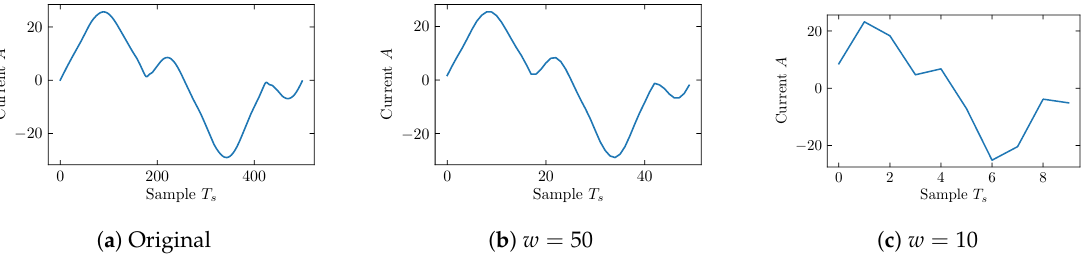
Figure 3. Illustration of dimension reduction with PAA for different embedding w : ( a ) The original activation current before dimension reduction; ( b ) The activation current after PAA with w =